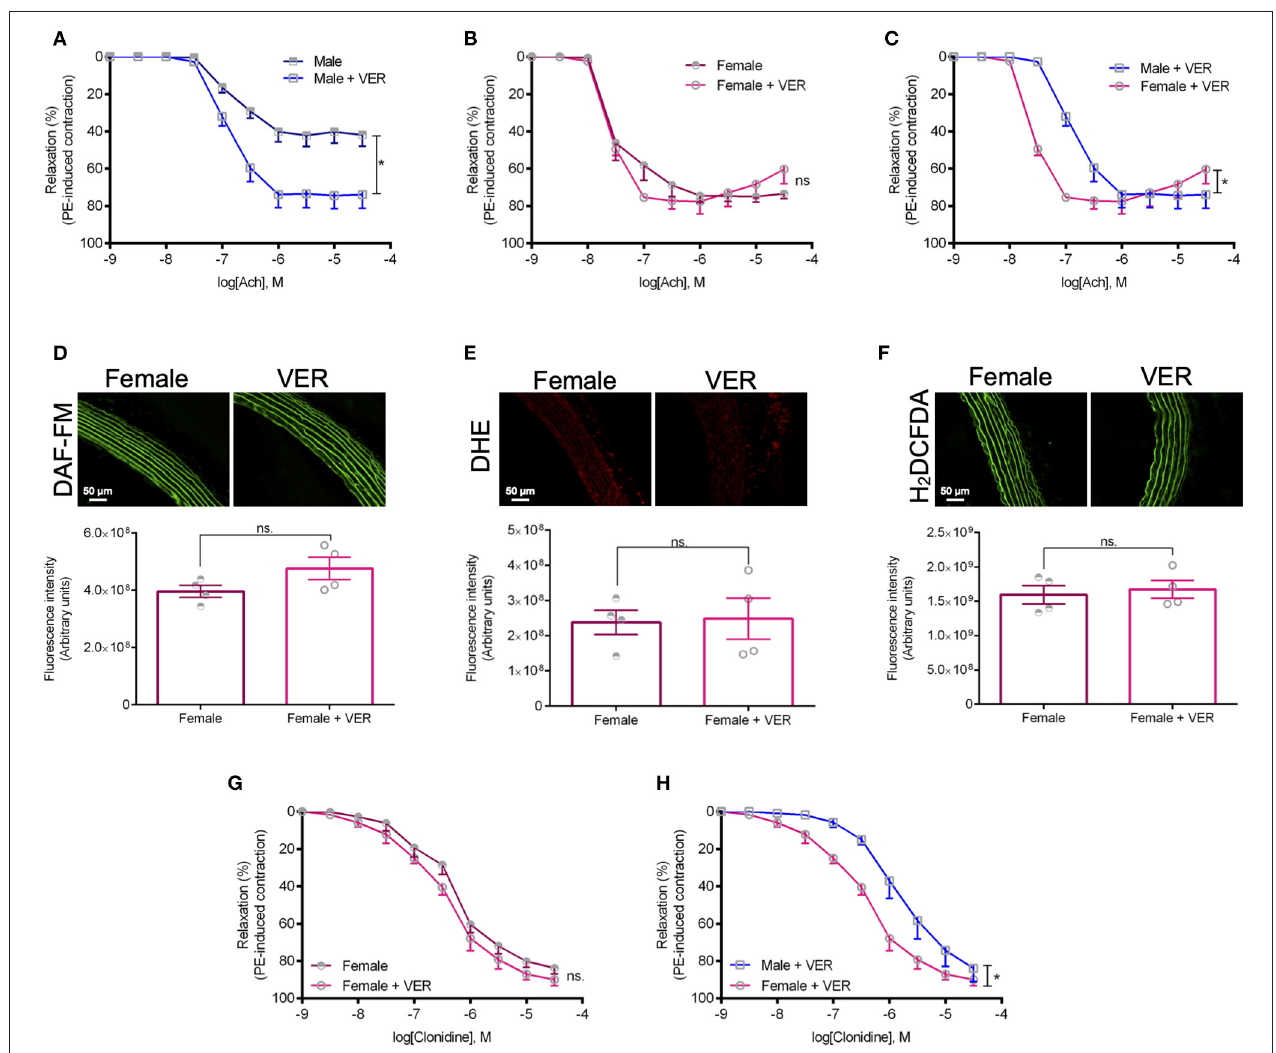
FIGURE 4 | The higher sensitivity of female rats to HSP70 inhibition does not involve an increase in NO-dependent vasodilation nor a decrease in vascular oxidative stress. (A–C) Show concentration-response curves to acetylcholine and (G,H) display concentration-response curves to clonidine. * p ≤ 0.05 using two-way ANOVA followed by the Bonferroni correction. The fluorescent probes DAF-FM (D) , DHE (E) , and H 2 DCFDA (F) were used to measure the levels of nitric oxide and vascular oxidative stress in isolated thoracic aorta from female rats incubated with vehicle or VER155008 (10 − 5 mol/L), and are displayed as arbitrary units. * p ≤ 0.05 using two-tailed Student’s t -test. Data are expressed as mean ± SEM, n =